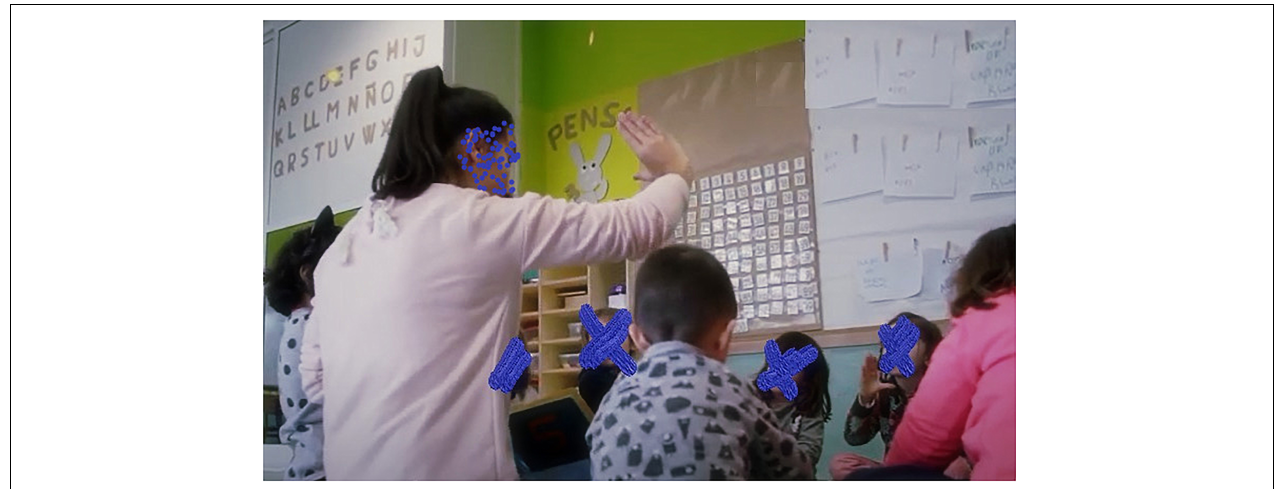
FIGURE 3 | Example of a video capture of a classroom and the problems it presents for the protection of personal data.